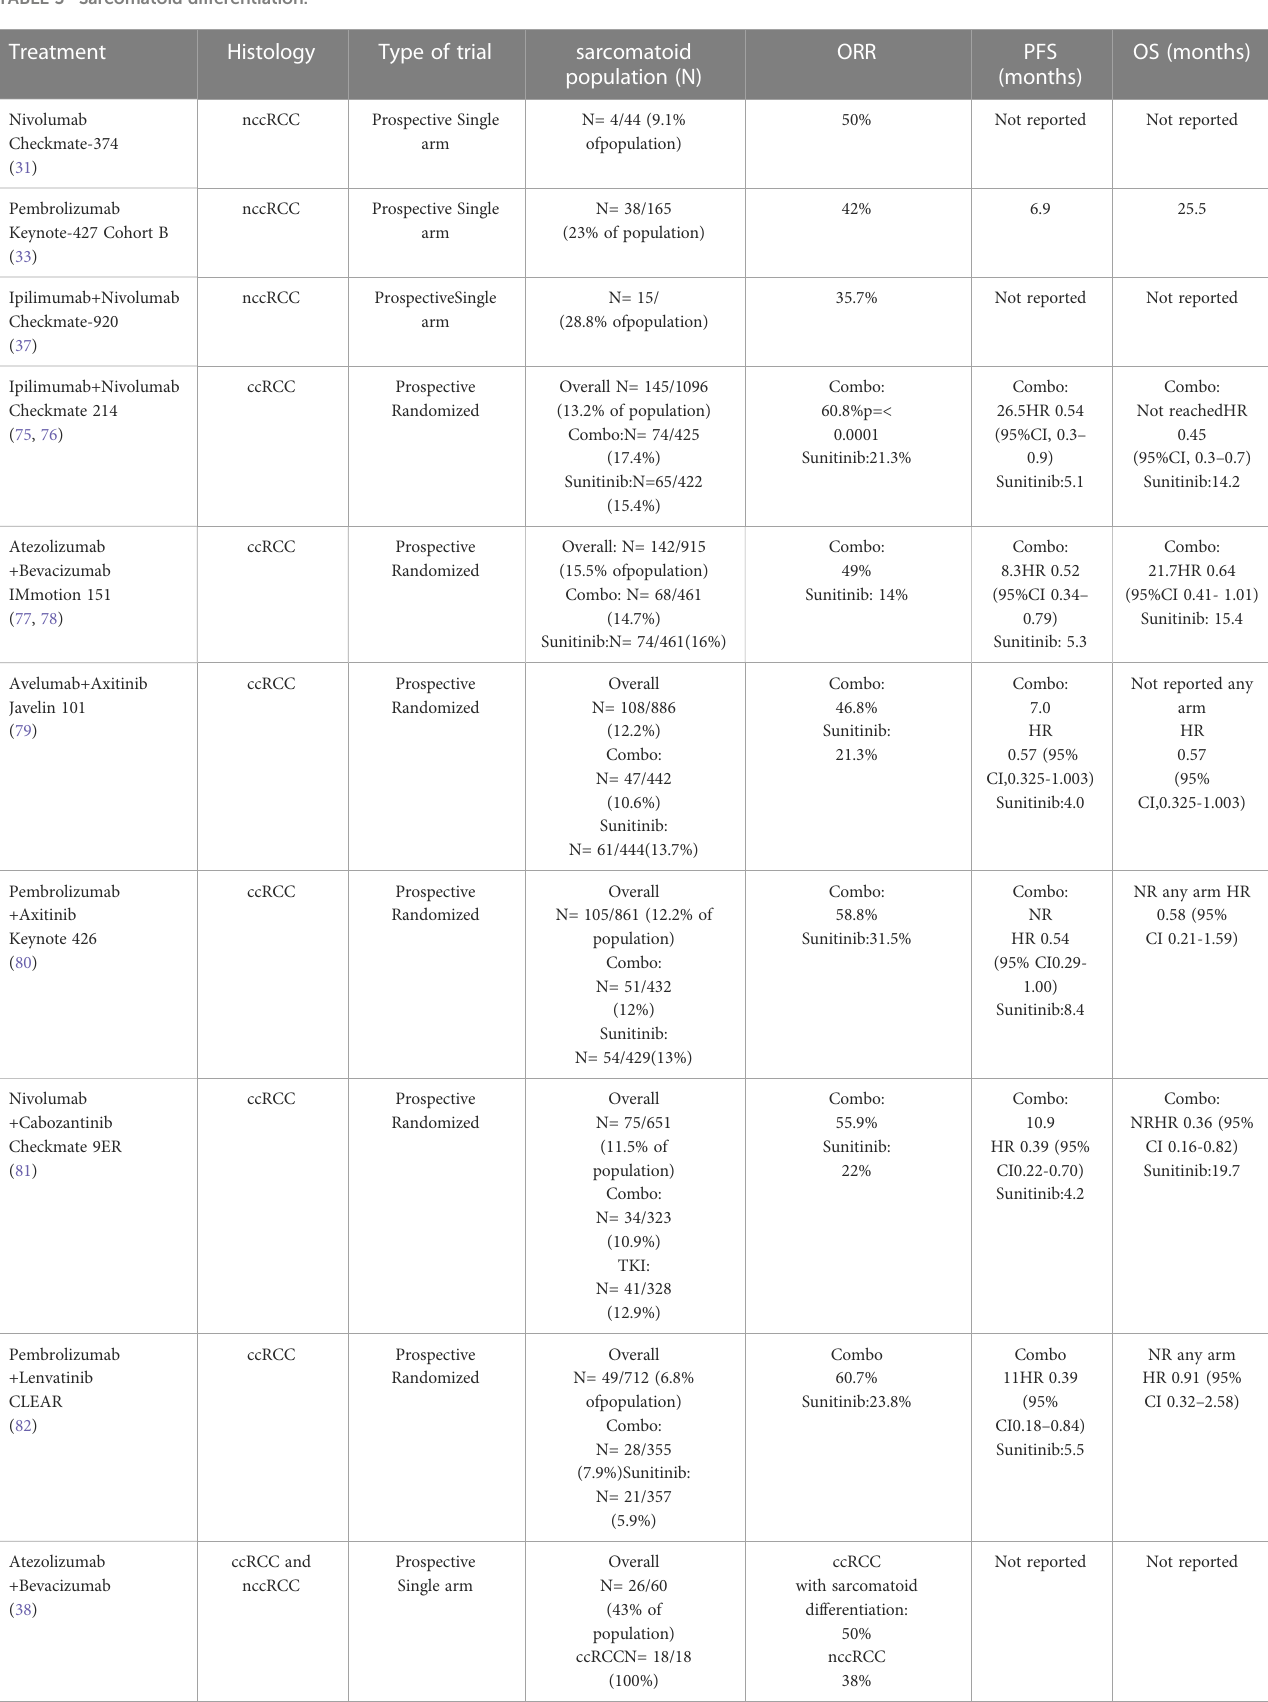
TABLE 3 Sarcomatoid